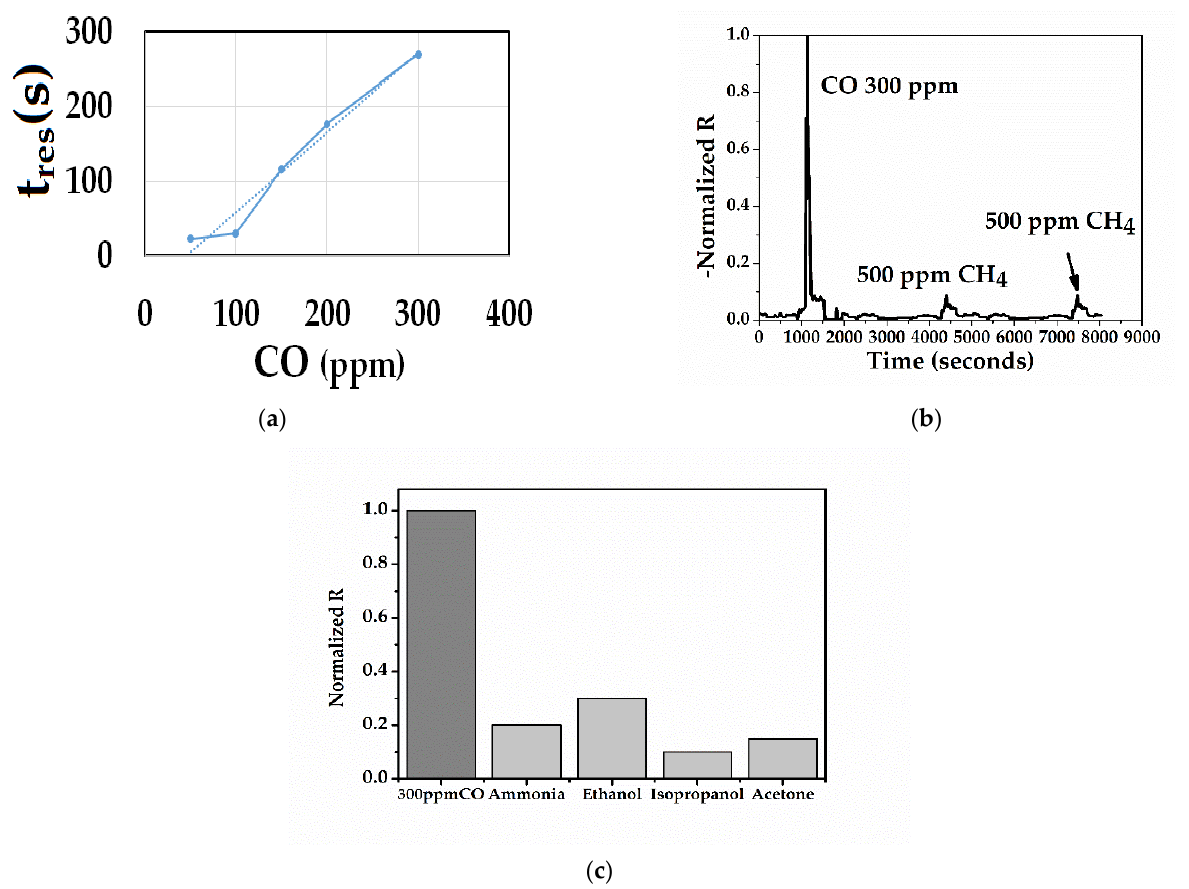
Figure 11. ( a ) Response time of the sensor at 50, 100, 150, 200, and 300 ppm CO; ( b ) selectivity of PANI:PSS/SWCNT/Fc in the presence of 500 ppm methane (at room temperature in the presence of dry air (N 2 and O 2 ); ( c ) selectivity of PANI:PSS/SWCNT/Fc (at room temperature in the presence of 100 ppm NH3, 2000 ppm ethanol, 1000 ppm acetone, and 200 ppm isopropanol).